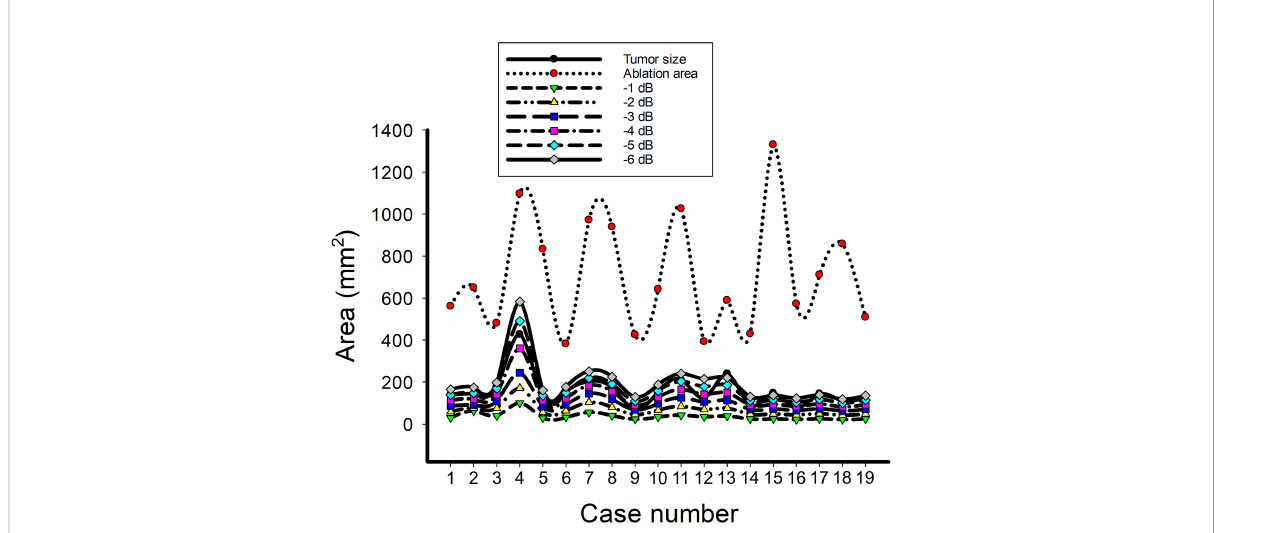
FIGURE 5 The data of the tumor size, ablation zone size, and S CBE j for each subject estimated according to various contour criteria. By adjusting the h s> 0 criteria from − 1 to − 6 dB contours, S CBE j increased accordingly and approximated the size of the tumor; nevertheless, the ablation zone size h s> 0 was smaller and less dependent on the ablation zone size.